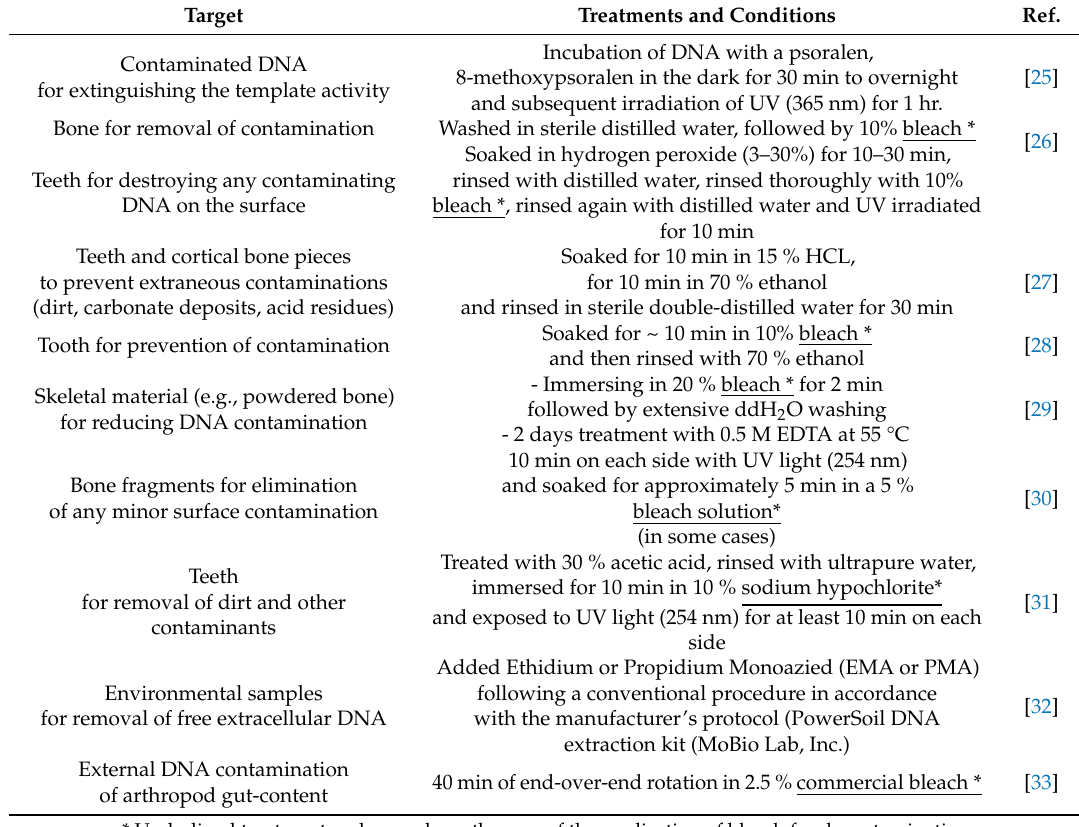
Table 1. Summary of previous treatment processes for decontamination in DNA